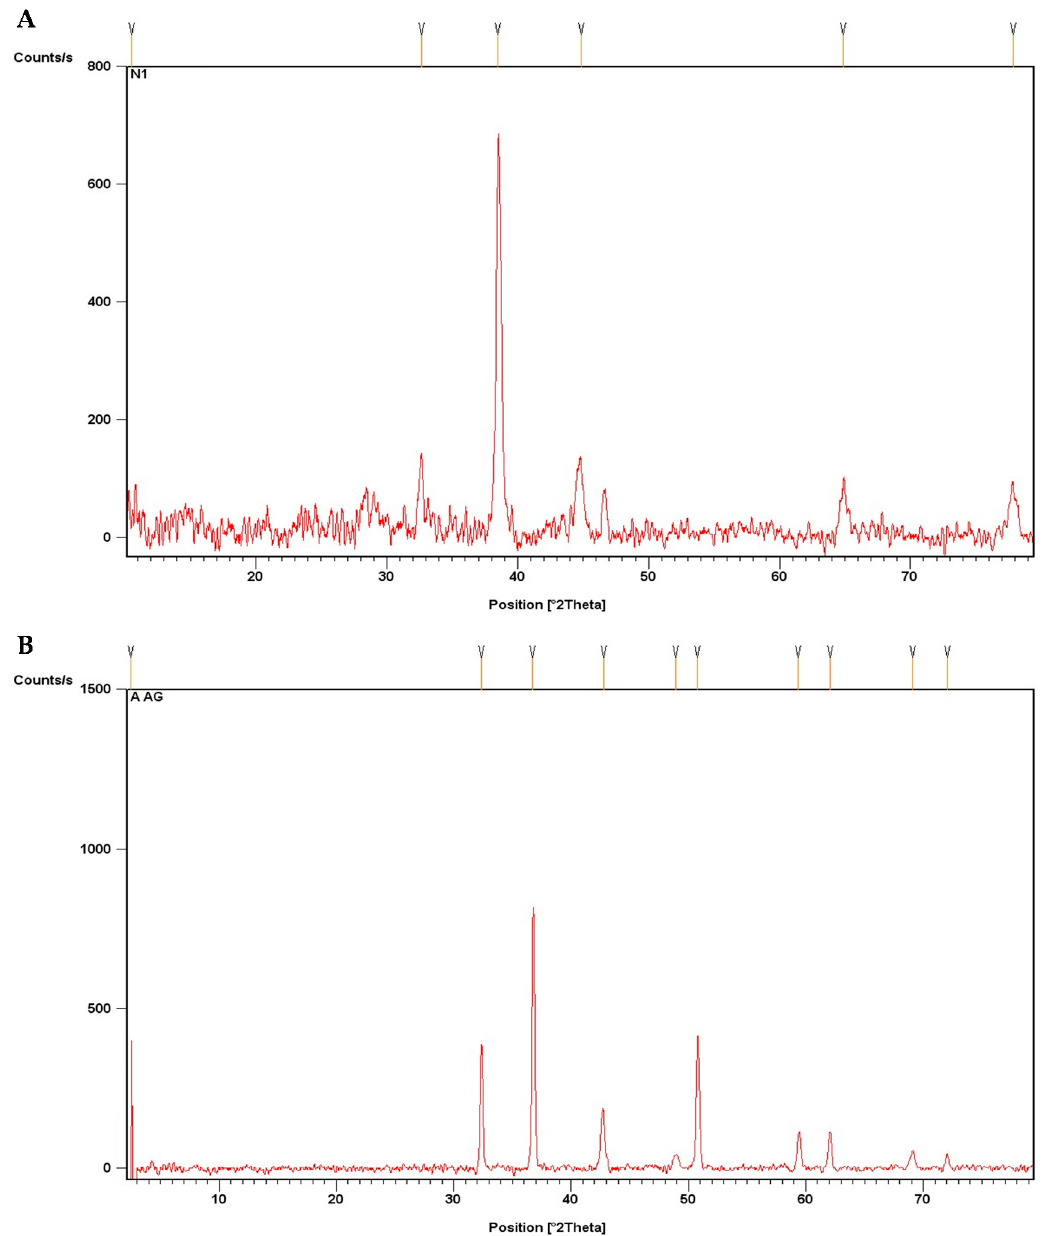
Figure 2. XRD analysis of AgNPs: ( A ) XRD image of BC-AgNPs; ( B ) XRD image of Figure 2 XRD analysis of AgNPs :( A ) XRD image of BC-AgNPs; ( B ) XRD image of AE-AgNPs.